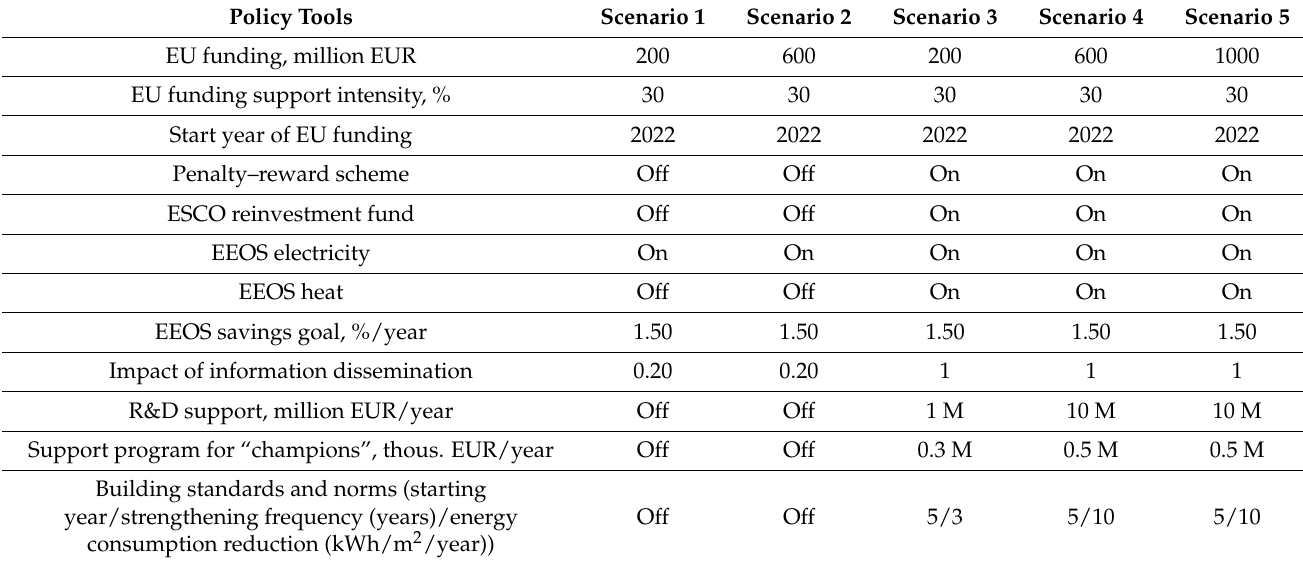
Table 2. Input data for policy tools for each policy